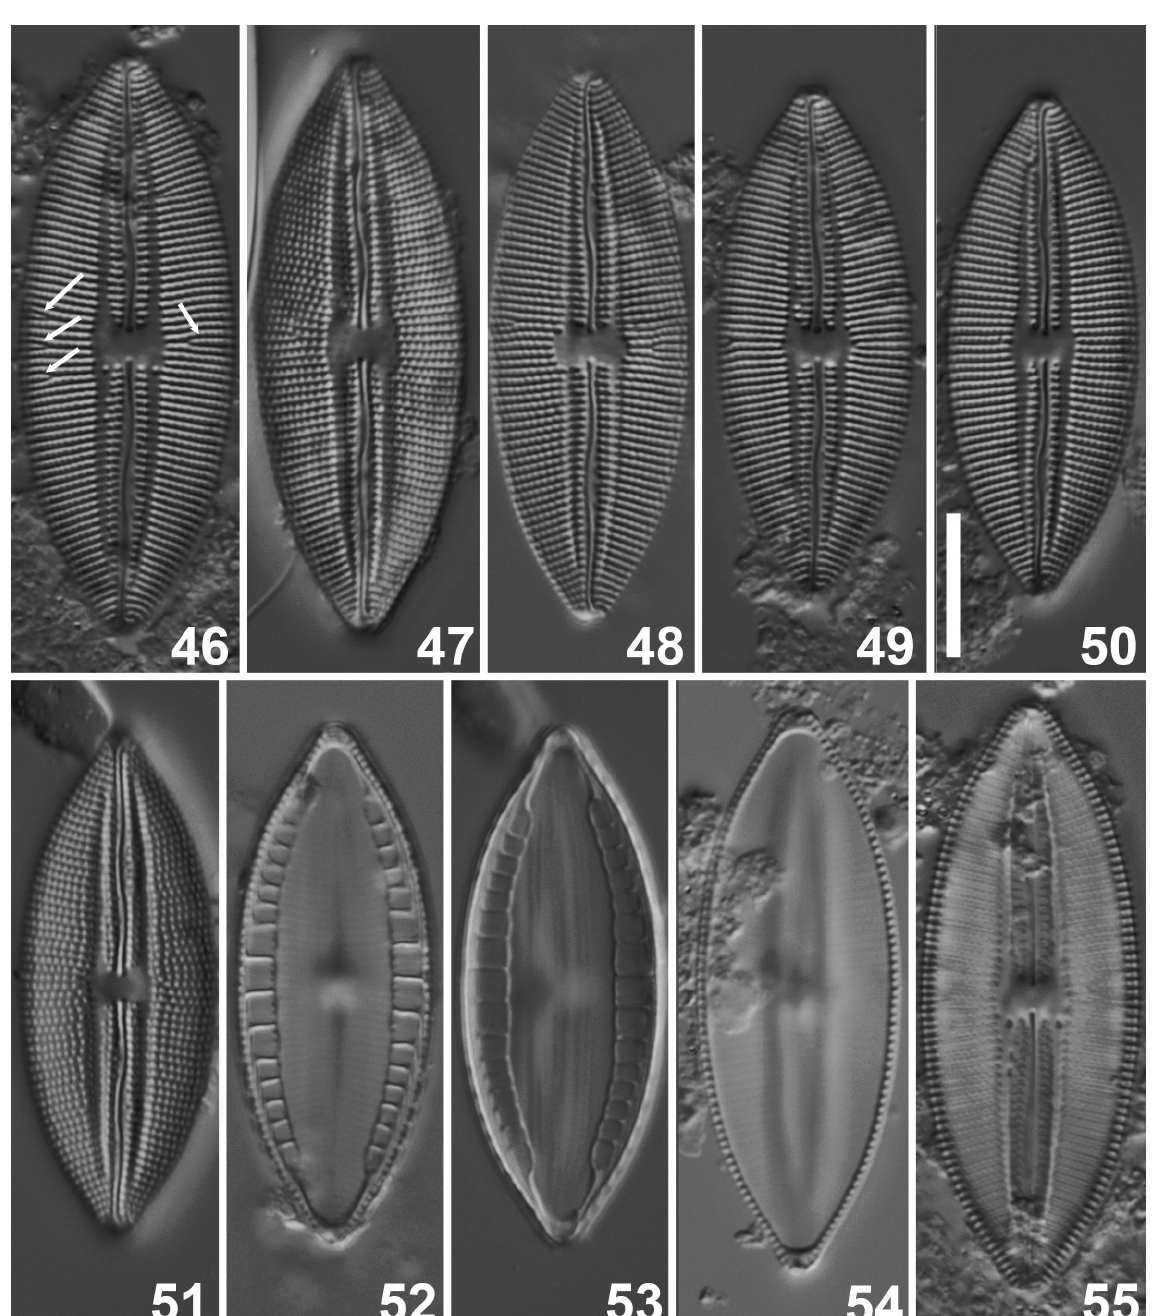
Figs 46–55. Mastogloia senegalensis Van de Vijver, Fofana, Sow & Ector sp. nov. Light micrographs of valves from the Lac de Guiers type population ( Van de Vijver sample SEN-42 ). 46–51 . LM views of several specimens showing variation in valve size and shape (the arrows in Fig. 46 show typical bifurcating striae near the central area). 52–53 . LM views of the partectal ring with the partecta. 54 . LM view of an entire valve with removed partectal ring showing the pseudosepta. 55 . LM view of an entire valve with removed partectal ring showing the valve interior. Scale bar: 10